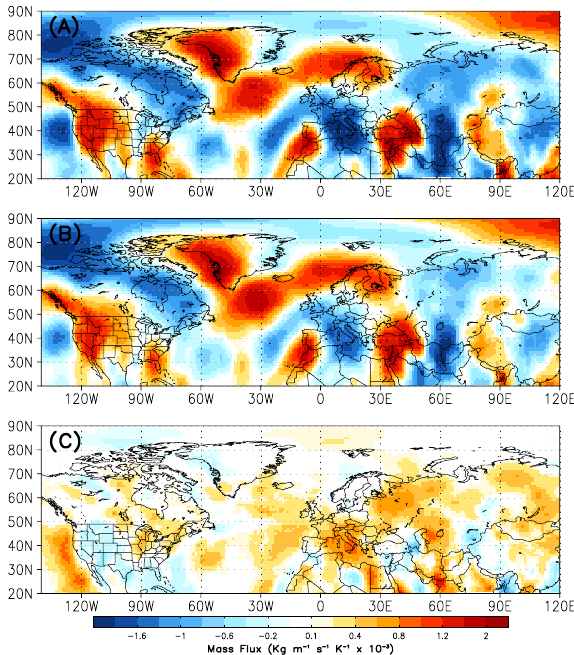
Fig. 3. Spatial structure of column integrated meridional mass flux averaged over the period June-July-August for (A) G4R20 and (B) G5F05. (C) Difference in meridional mass flux, or (B) mi- nus (A) .